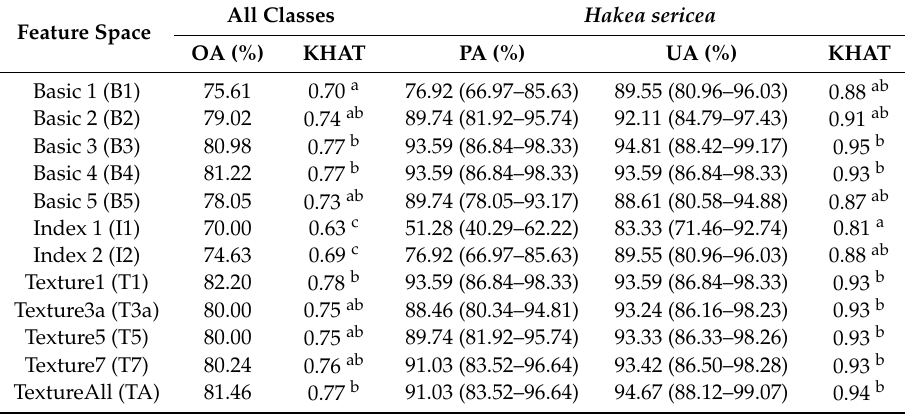
Table 3. General accuracy results for the WorldView-2 (WV2) study. Overall Accuracy (OA), Producer’s Accuracy (PA), and User’s Accuracy (UA) values are expressed in %. The Wald adjusted confidence intervals ( p < 0.05) are shown for PA and UA. Along the KHAT column, figures presenting different letters indicate significant differences for the KHAT statistic ( p <